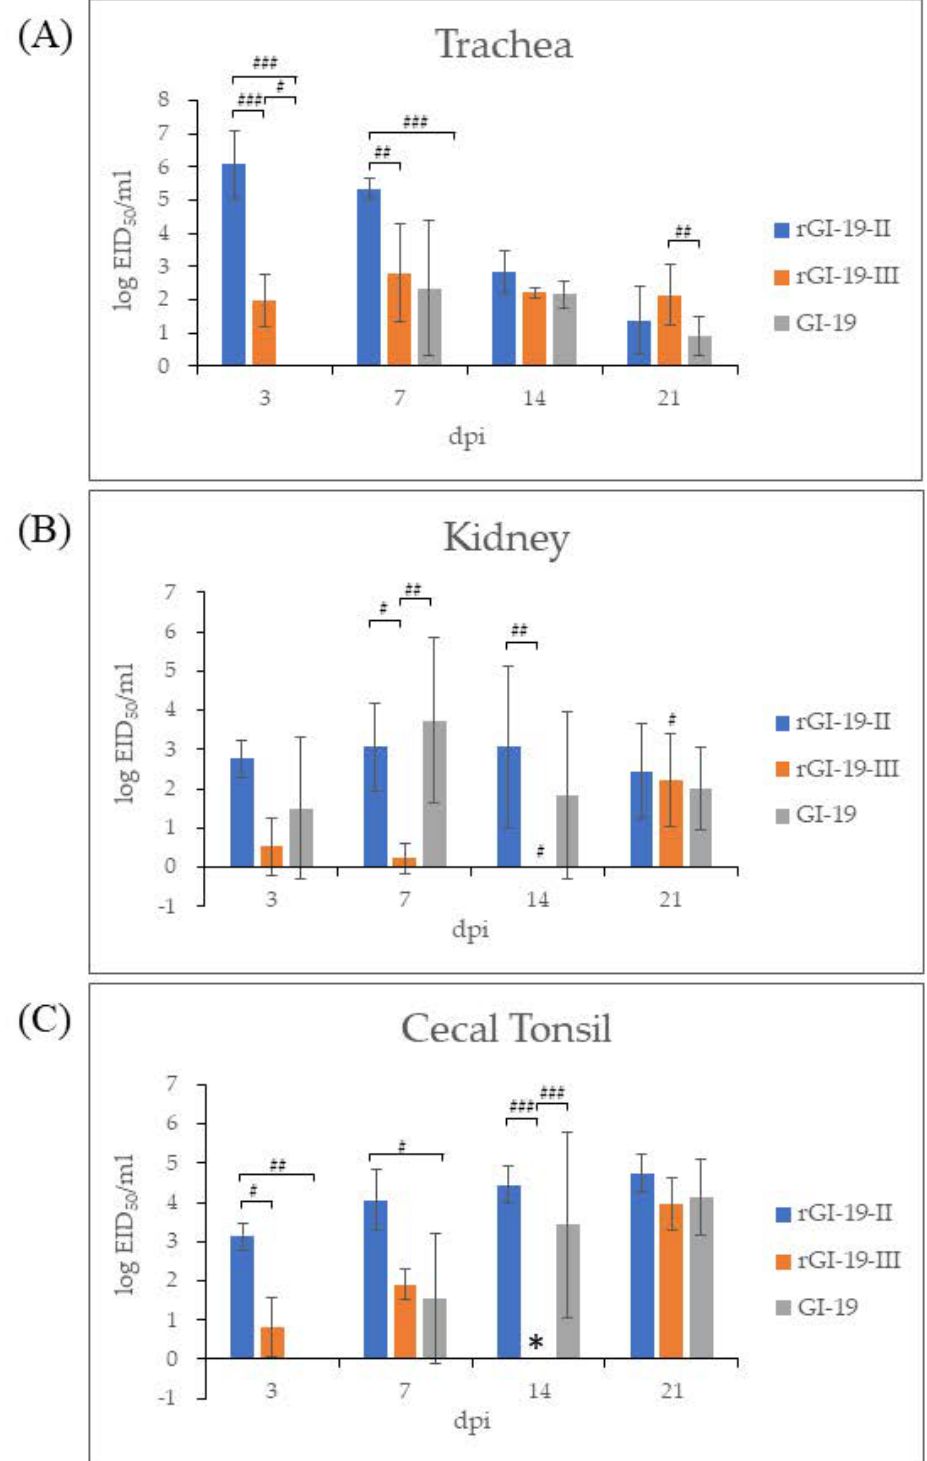
Figure 5. IBV viral load in different tissues (trachea ( A ), kidney ( B ), and cecal tonsil ( C )) from chickens, as measured by RT-qPCR. The error bars represent the standard deviation. *: Negative result may be due to errors during sample processing. #: p < 0.05; ##: p < 0.01; ###: p <